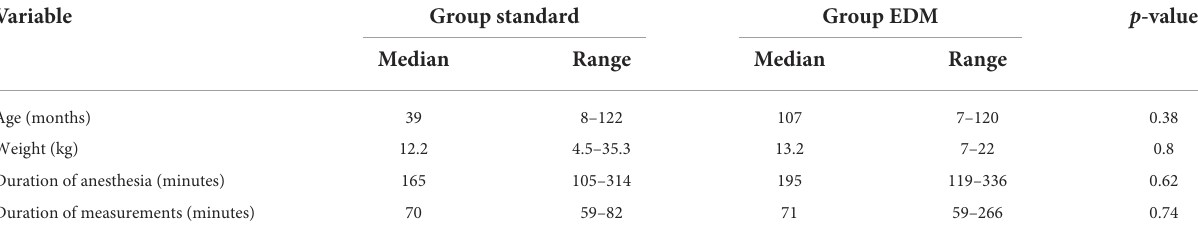
TABLE 1 Median and range of age, weight, duration of anesthesia, and duration of measurements in 14 clinical canine patients receiving intraoperative fluid therapy based on two different treatment algorithms [standard and esophageal Doppler monitor (EDM)].